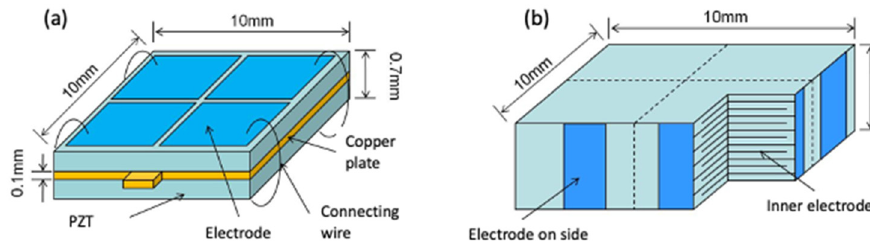
Figure 7. Schematic design of ( a ) bimorph and ( b ) multi-layer piezoelectric actuators.